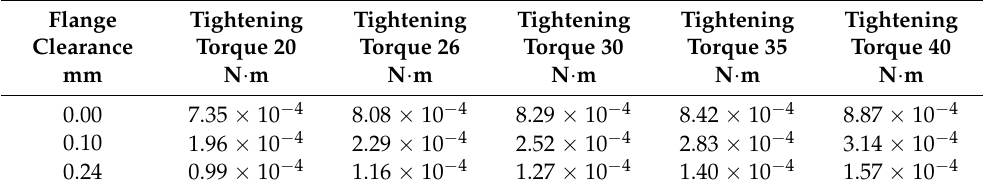
Table 3. The experimental contact area ratio data for the assembled experimental section of the 304 stainless steel–Q345R material.